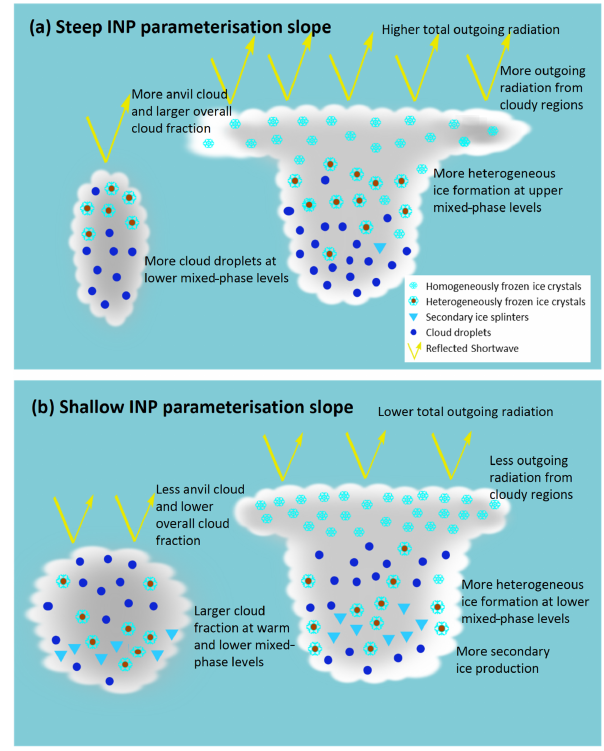
Figure 9. Schematic of the main effects of the INP parameterisation slope (i.e. a steep (a) or shallow (b) temperature dependence of INP number